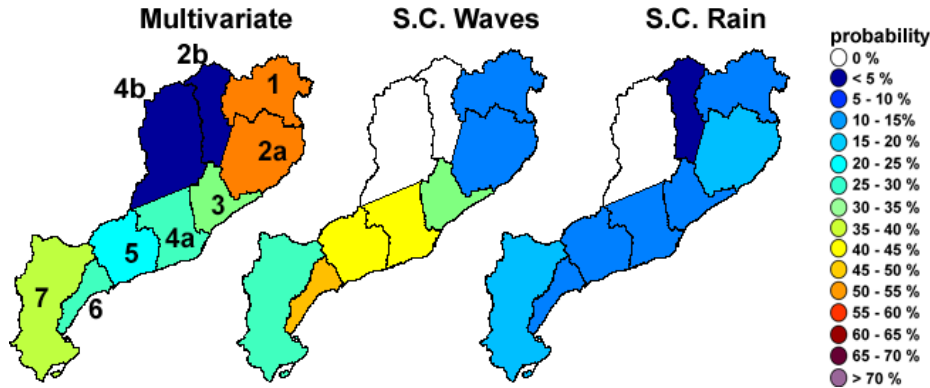
Figure 6. Probability of occurrence of the different types of compound events along the Catalan coast. Multivariate (local simultaneous rainfall and wave storm episodes); SC-waves (local wave storm episodes and simultaneous rainfall in a different area); SC-rain (local rainfall episode and simultaneous wave storm in a different area). Probabilities are given with respect to the presence of a compound event (average occurrence during the period 1973–2013 of about 3.4eventsyr − 1 ). Probabilities are given per each area along the coast, and the sum of the different types of events per area does not necessarily reach 100% due to cases in which neither rainfall nor wave storms locally occur. Area numbers are specified on the map on the left.